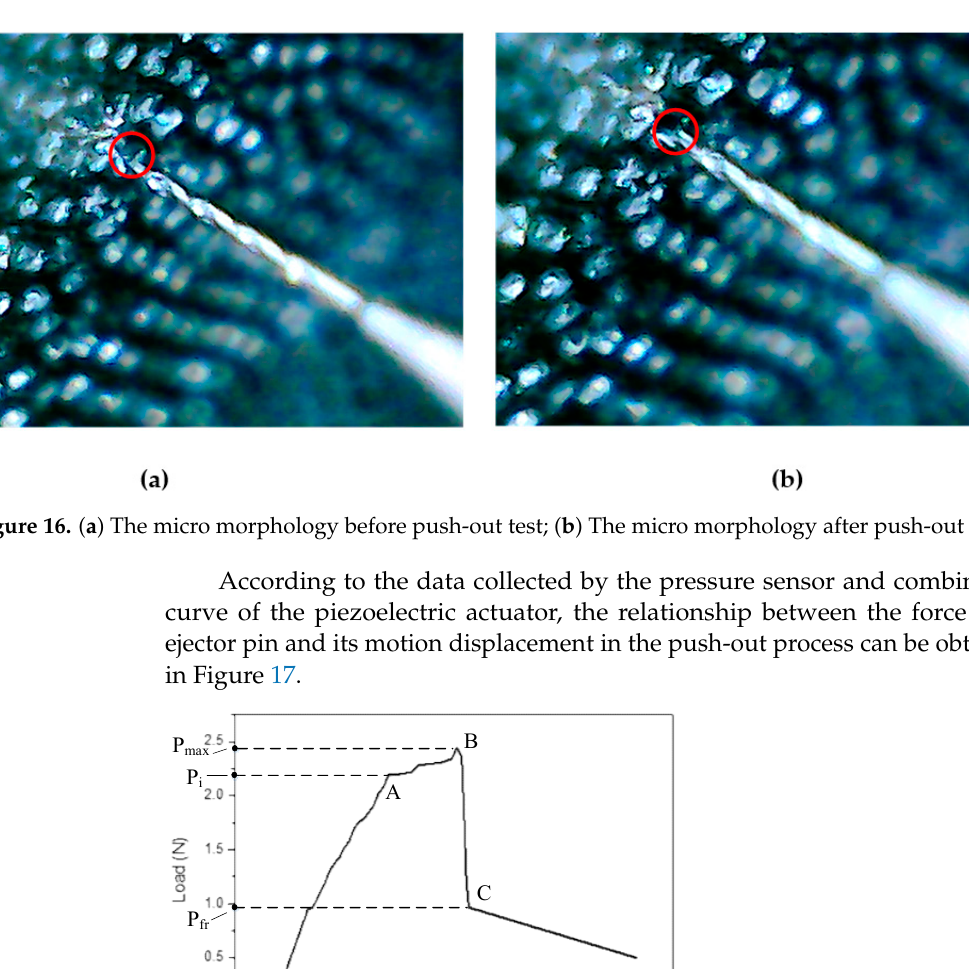
14 of 19 Figure 15. The performance of the piezoelectric actuator. 4.3. Fiber Push-Out Test The part of the ejector pin and the fiberglass sheet under the microscope before and